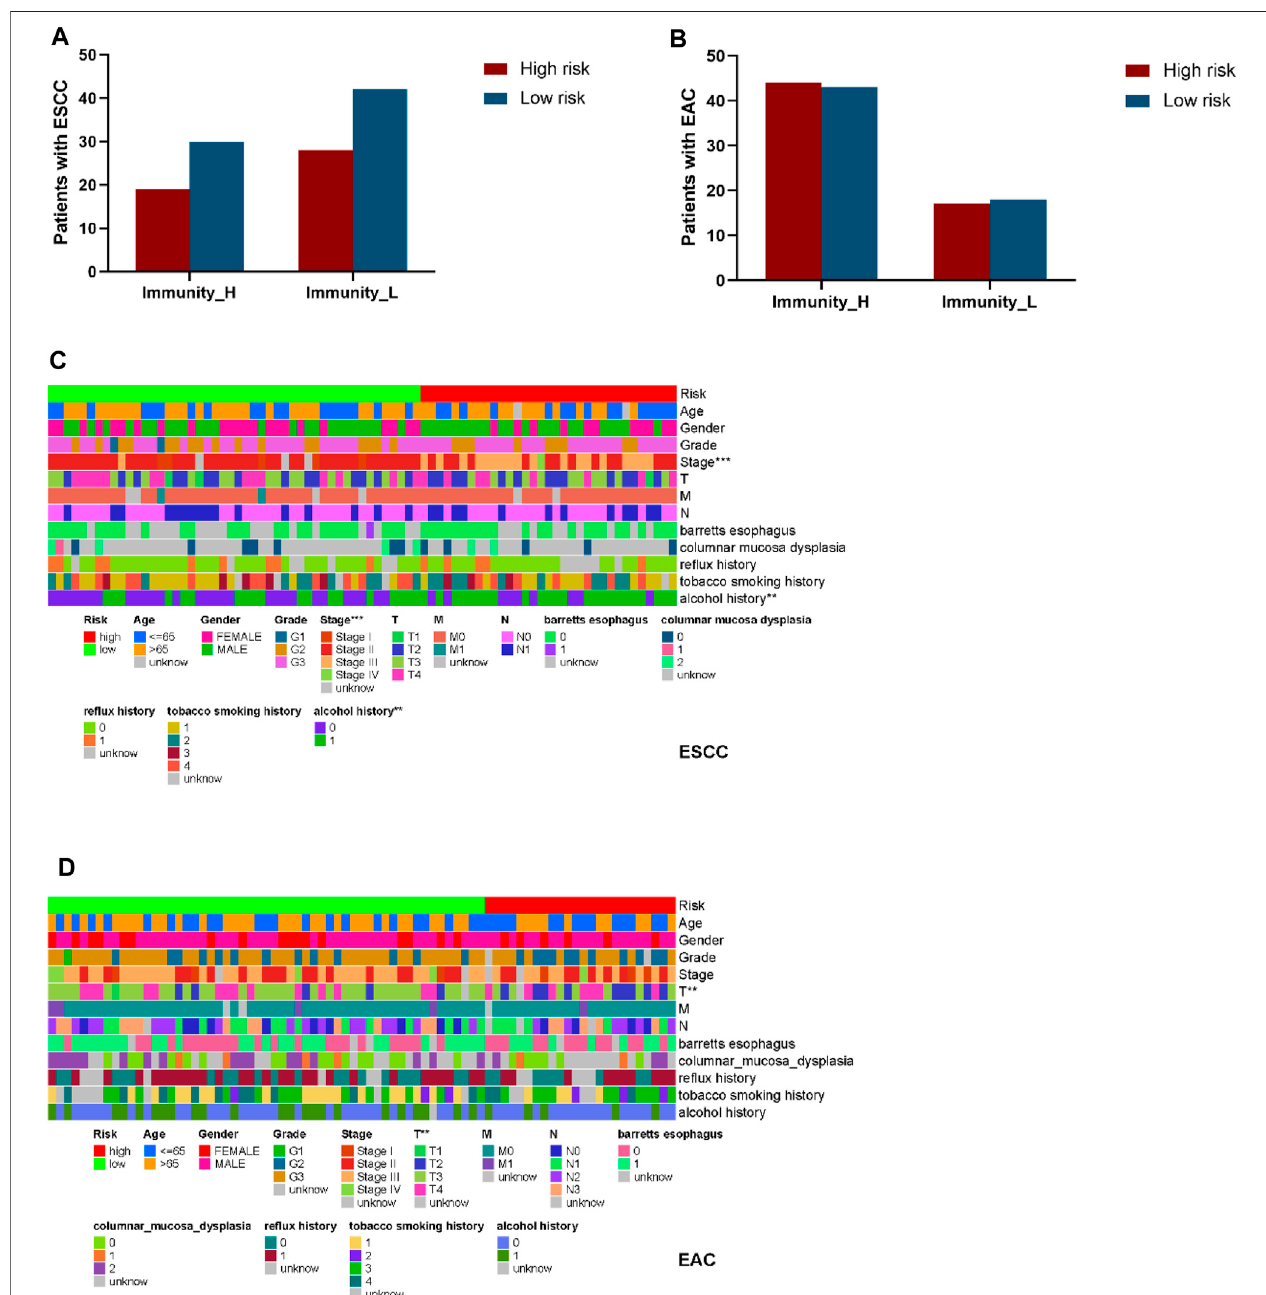
FIGURE 5 | Clinical traits and TILs correlated analyses for esophageal cancer patients. (A) The constituent proportion of high- and low-risk patients in immunity clusters in ESCC. (B) Constituent proportion of high- and low-risk patients in immunity clusters in EAC. (C) Heatmap of clinical traits correlated with risk in ESCC. (D) Heatmap of clinical traits correlated with risk in EAC. (E) Correlation between risk and TILs in ESCC. (F) Correlation between risk and TILs in EAC. T, Depth of tumor invasion; M, Metastasis; N, Lymph Node; * p < 0.05; ** p < 0.01; *** p < 0.001.